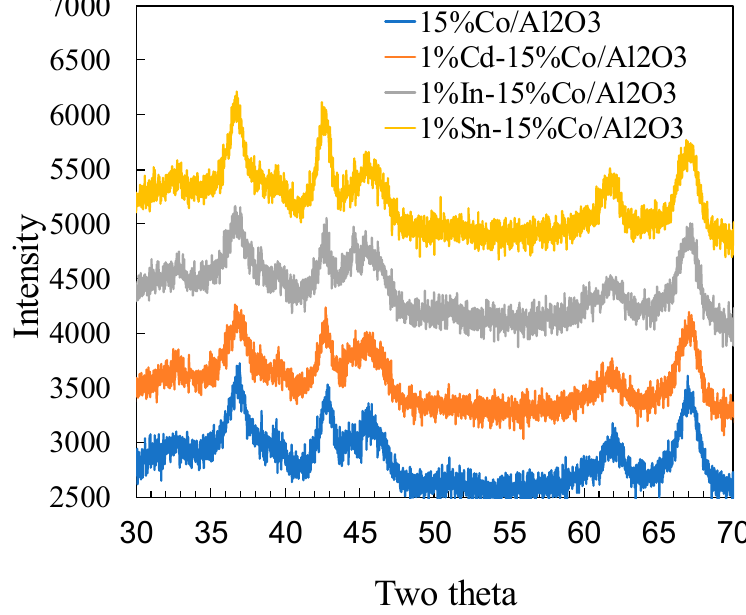
Figure 3. XRD patterns unpromoted and Cd, In and Sn promoted 15%Co/Al 2 O 3 catalysts.